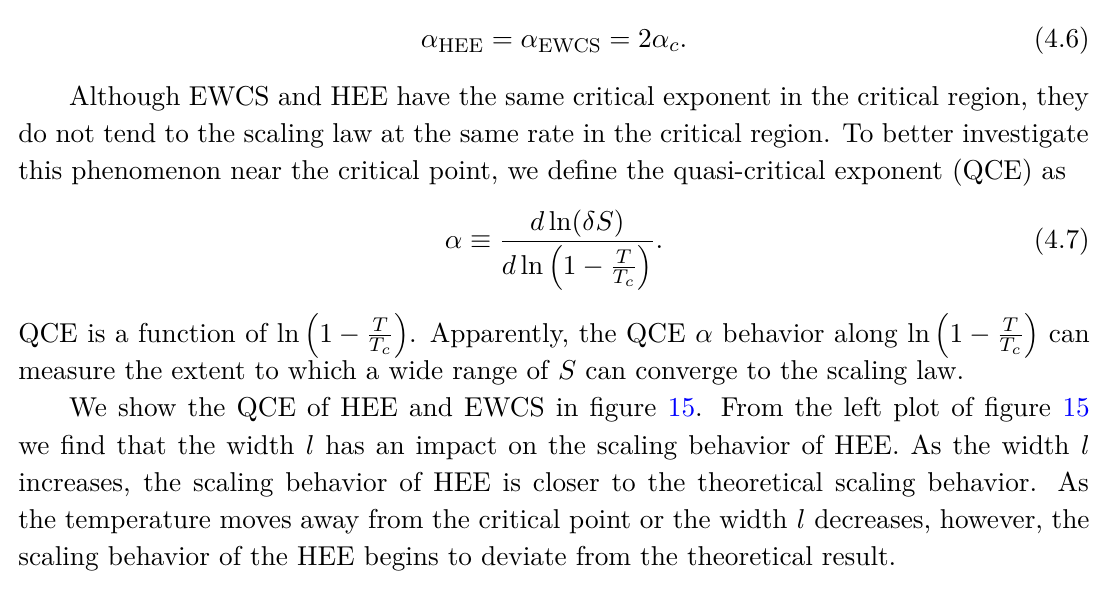
Figure 15 . The QCE of the HEE and EWCS. The red dashed line represents the twice QCE of the condensate h J x i . Left plot: the QCE of the HEE near the critical points. Right plot: the QCE of the EWCS near the critical points, when we fix the a = 2 and c = 1 . 5